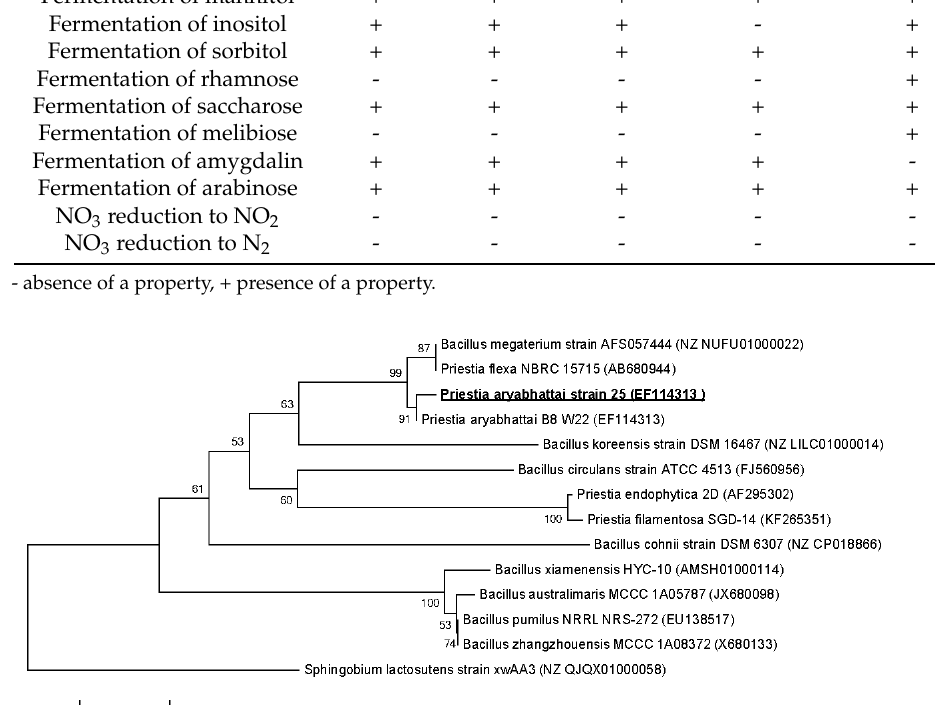
Figure 7. Phylogenetic position of strain Pseudomonas chlororaphis 3 based on the results of the com- parative analysis of the nucleotide sequences of the 16S rRNA genes. The scale corresponds to 5 nucleotide substitutions per every 1000 nucleotides (evolutionary distance). The neighbor-joining method was used. The root was determined by including the sequence of Azotobacter vinelandii DSM576 (AY336565) as an external group. 3.4. Biochemical Characteristics of Soil Strains The determination of the biochemical characteristics of the cultures using the API 20 E and API 50 CH tests revealed the following features (Tables 3 and 4). The biochemical profiles of strains 18, 27 and 28 were almost identical to each other and very close to the species Bacillus subtilis ATCC 6051 T . All three strains were urease-negative. They showed the ability to liquefy gelatin and utilize citrates, as well as a wide range of carbon sources—namely, glycerol, L-arabinose, D-ribose, D-xylose, D-glucose, D-fructose, D- mannose, inositol, D-mannitol, D-sorbitol, salicin, D-cellobiose, D-maltose, D-melibiose, D-sucrose, D-trehalose and inulin. The studied strains cleaved potassium 2-ketogluconate and potassium 5-ketogluconate and also showed pronounced hydrolytic activity with re- spect to starch and glycogen, weak with respect to turanose.